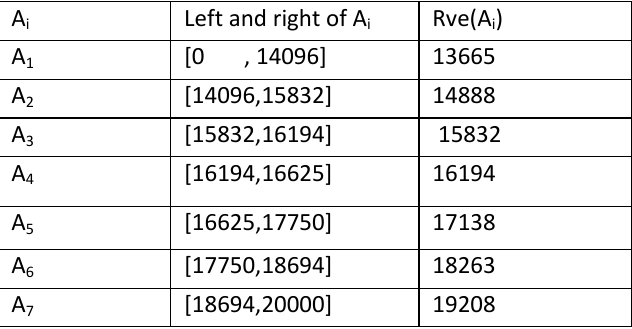
Table 2. Shown left, right and Rve. of A